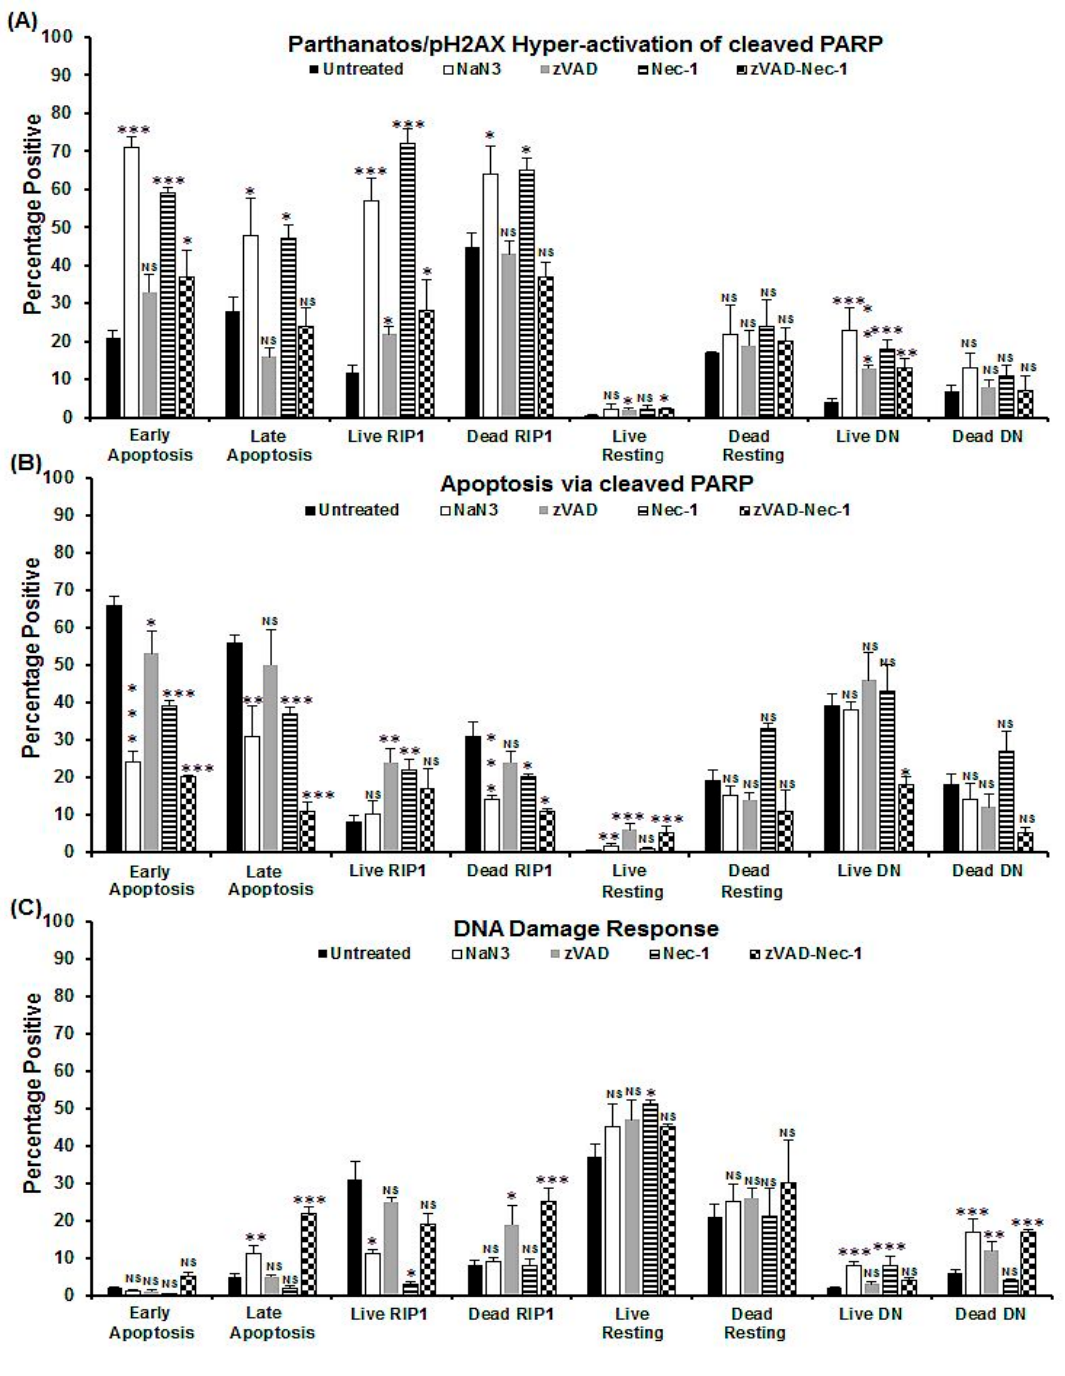
Figure 3. Parthanatos / hyper-activation of cleaved PARP, apoptosis via cleaved PARP, and DDR analysis of oncosis. Untreated Jurkat cells, treated with 0.25% NaN 3 for 24 h, or pre-treated with zVAD (20 µ M) and / or Nec-1 (60 µ M) for 2 h, then incubated with 0.25% NaN 3 . Gating live and dead cells from a Zombie NIR vs. caspase-3-BV650 plot then both were analysed on a RIP3-PE vs. caspase-3-BV650 plot. Next, early and late apoptotic, necroptotic / resting, RIP1-dependent apoptotic, and double negative (DN) populations were analysed for pH2AX and cleaved PARP (Figures S2, S3). The incidence of ( A ) parthanatos / hyper-activation of cleaved PARP, ( B ) apoptosis via cleaved PARP, and ( C ) DDR were determined for all populations listed above. n = 3, % Mean, error bars % SEM, Student’s t -test; NS (not significant), * p < 0.05, ** p < 0.01**, *** p < 0.001 compared with untreated cells.